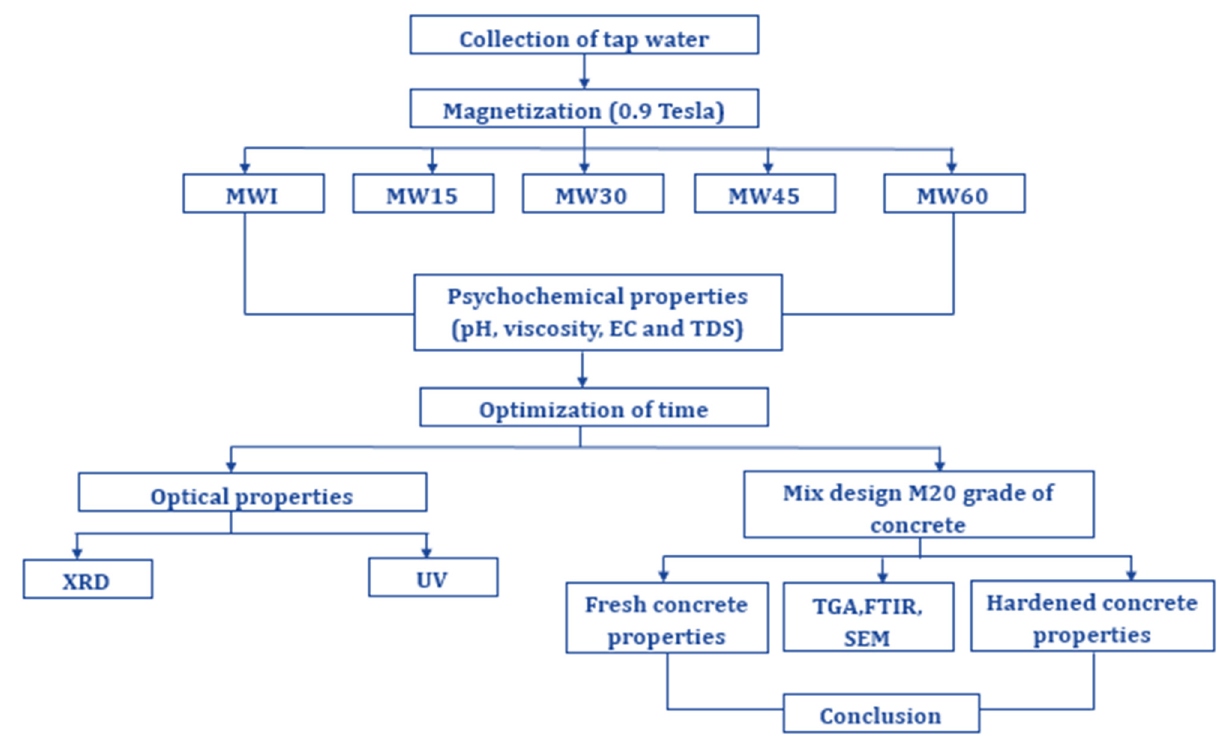
Figure 2. Research